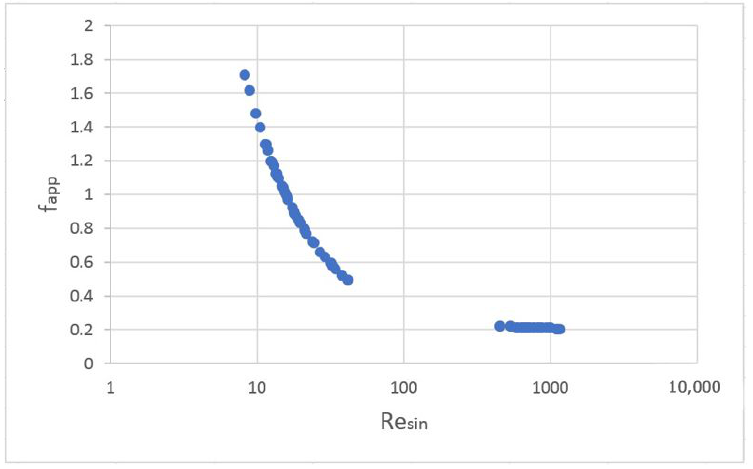
Figure 2. Variation of apparent friction coefficients ( f app ) with Re sine in the present